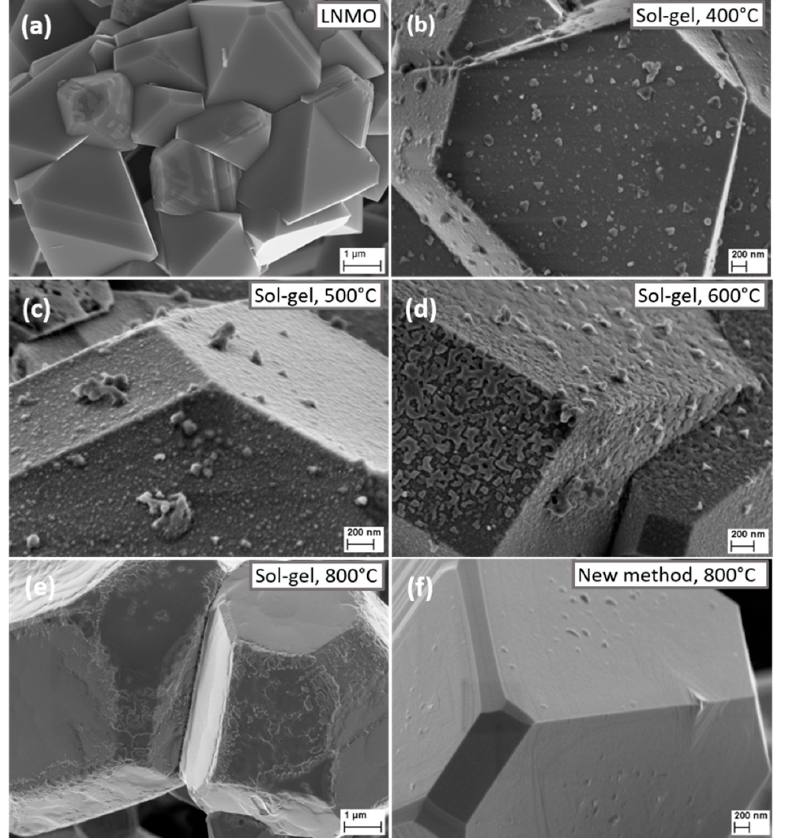
Figure 1. Scanning electron microscope (SEM) diagrams of samples ( a ) bare LMNO, ( b ) LMNO- LNbO-400, ( c ) LMNO-LNbO-500, ( d ) LMNO-LNbO-600, ( e ) LMNO-LNbO-800 and ( f ) LMNO- nLNbO-800.